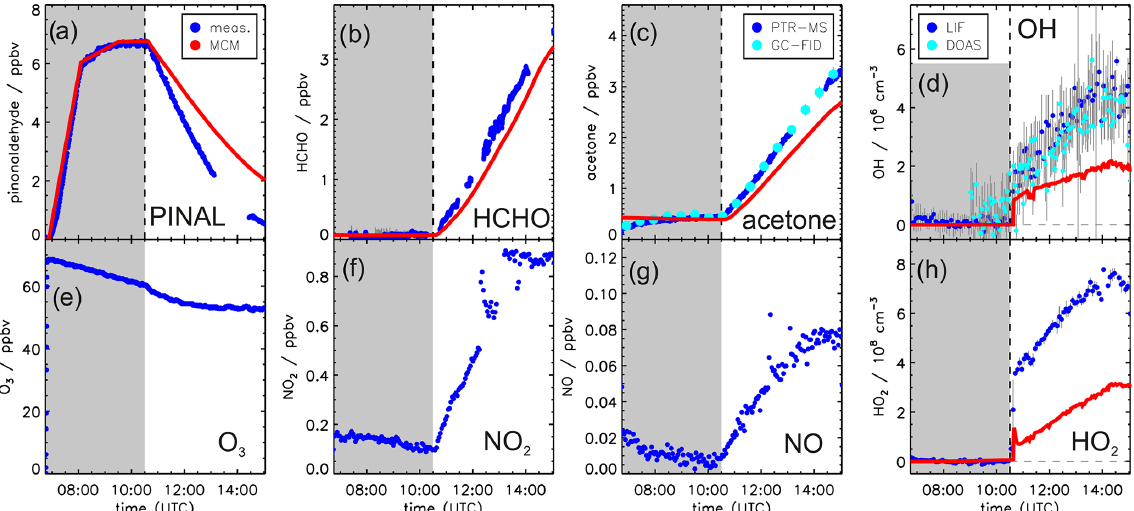
Figure 3. Measured and modeled trace gas concentrations during the photooxidation of pinonaldehyde without OH scavenger. In this exper- iment, pinonaldehyde is removed by photolysis and reaction with OH. Measured O 3 , NO 2 , and NO were used as constraints for the model. Grey-shaded areas indicate times when the chamber roof was